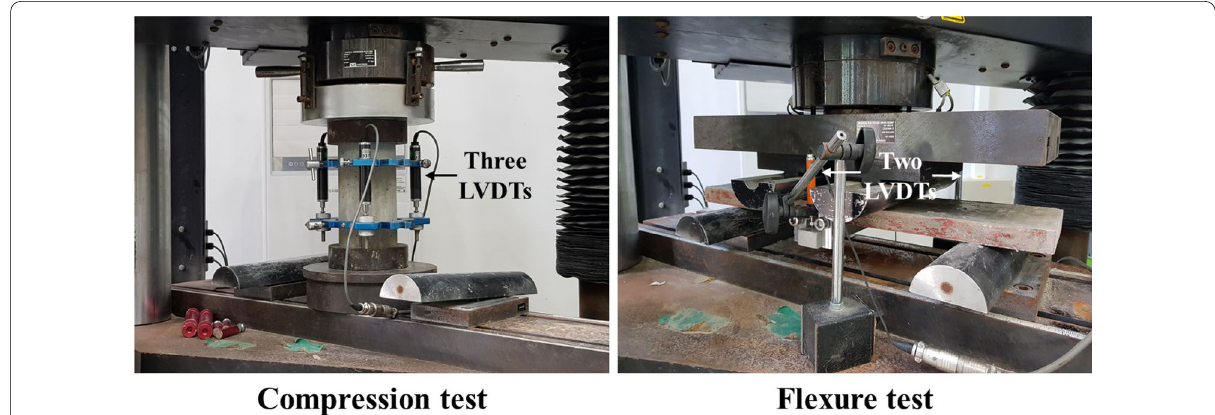
Fig. 8 Test setup for compression and flexure tests